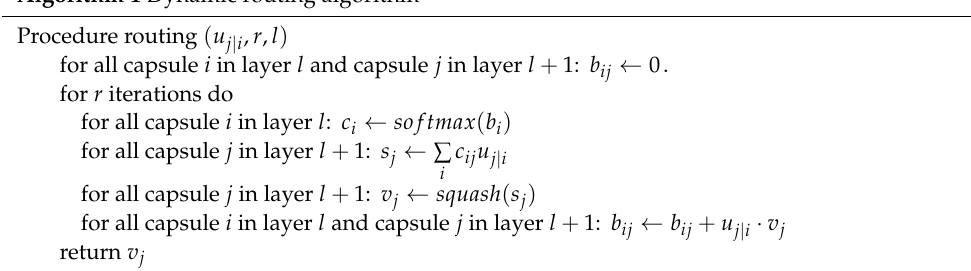
Algorithm 1 Dynamic routing algorithm